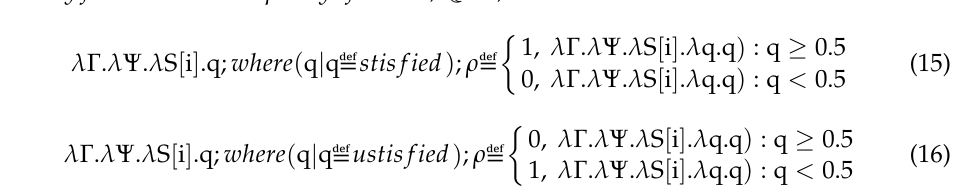
Table 3 defines a formal representation of trust-based SOA-IoT by using HOL sym- bols and interaction ways between IoT entities.